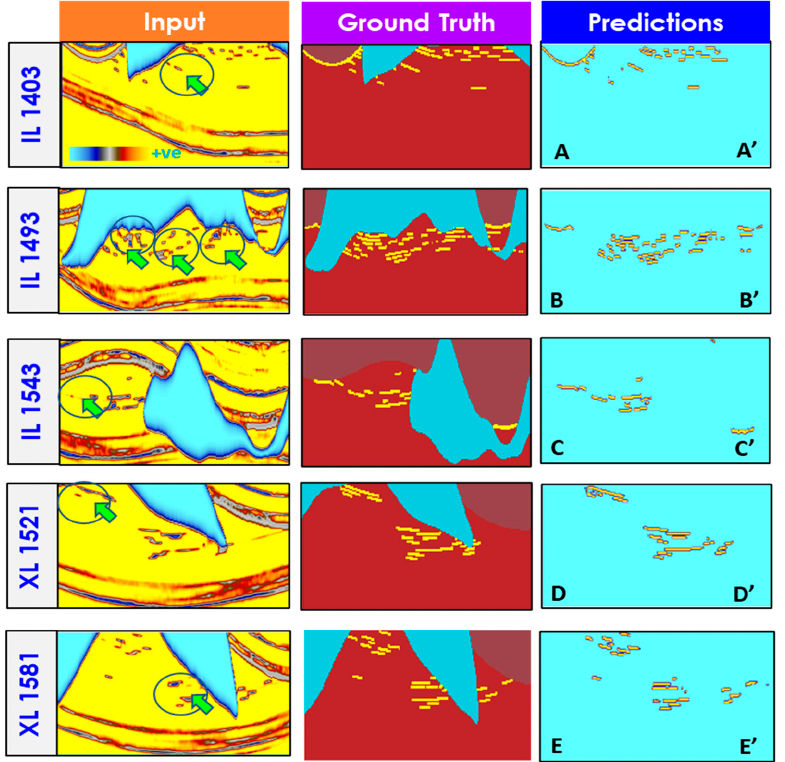
Figure 8. Overall input dataset, label data and prediction results from the five (5) geological cross- sections. (Input Column): Green arrows indicate subtle distributary channel series unable to be cap- tured by sweetness attributes. (Ground truth Column): The dataset was built using a blob-based